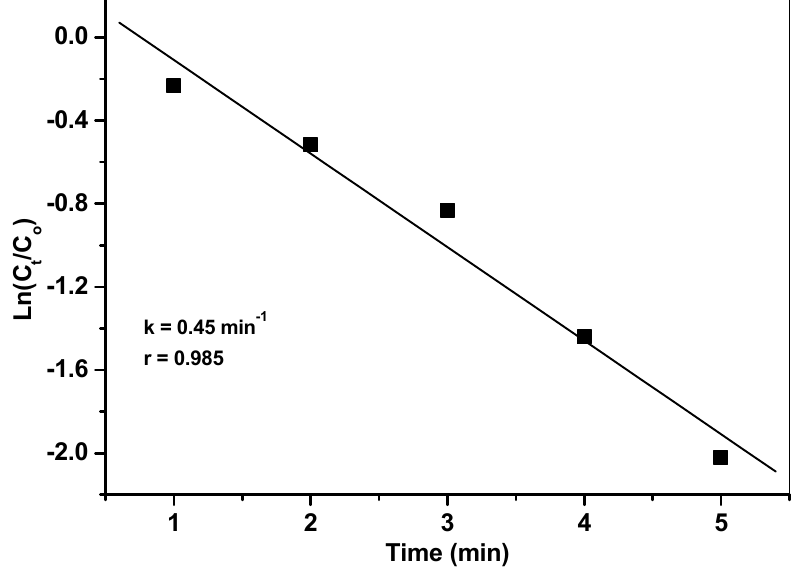
Figure 7. Kinetics plot of ln( C t / C 0 ) of NB reduction versus time using a PSE-capped Cu 2 O/CuO catalyst.